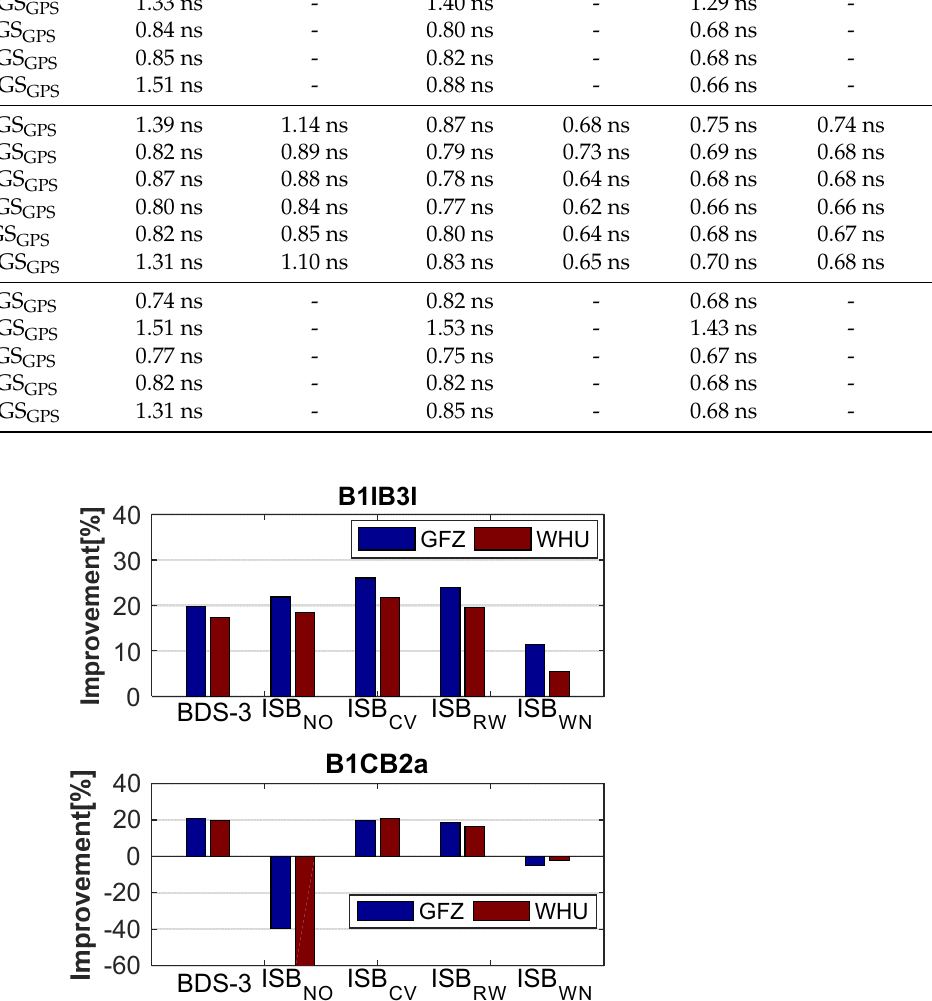
Figure 14. Percentage improvement in the stability of BDS clock differences compared to BDS-2- only solution.